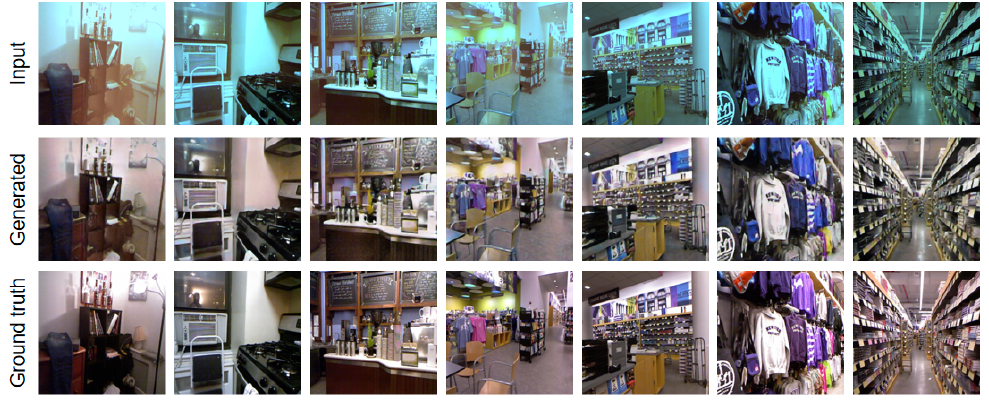
Figure 10. Generated results of the synthetic